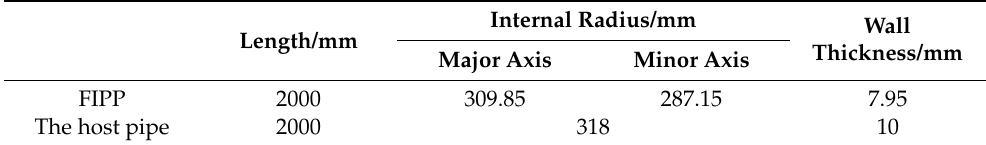
Figure 1. Experimental system design and geometric dimensions of equipment. Table 1. Geometrical dimensions of FIPP liner and host pipe.